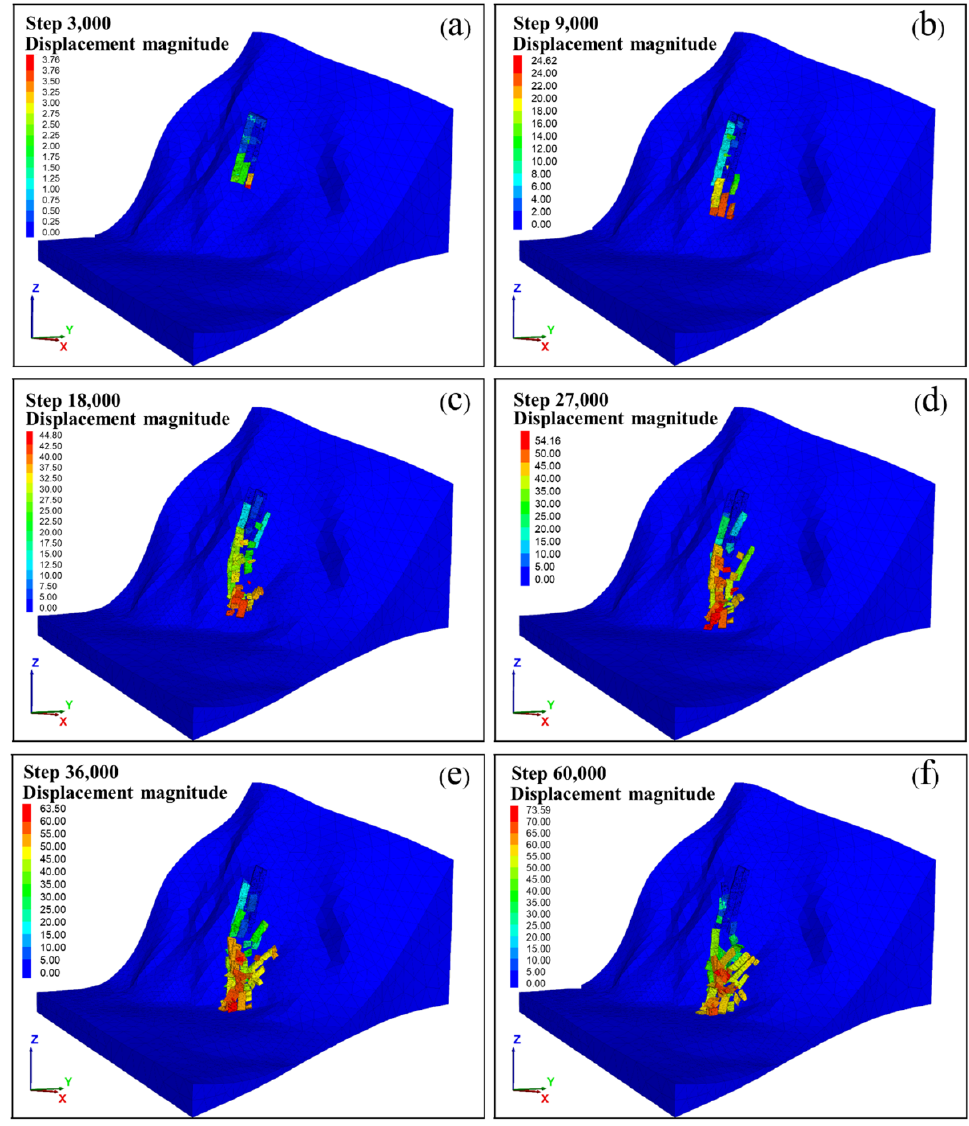
Figure 13. Failure simulation sequences of the dangerous rock mass. ( a ) simulation results at 3,000 cycles; ( b ) simulation results at 9,000 cycles; ( c ) simulation results at 18,000 cycles; ( d ) simulation results at 27,000 cycles; ( e ) simulation results at 36,000 cycles; ( f ) simulation results at 60,000 cycles.